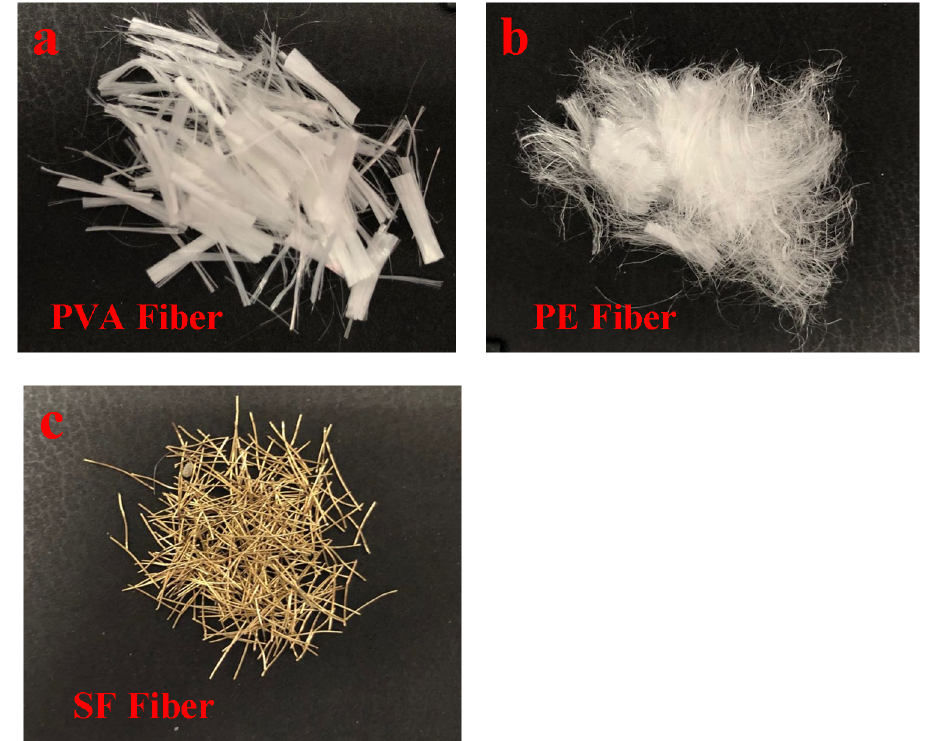
Figure 2: Morphology of three fi bers: ( a ) PVA fi ber, ( b ) PE fi ber, and ( c )